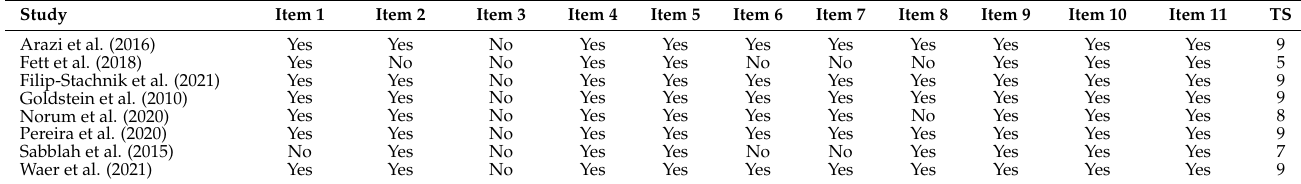
Table 2. Results from the PEDro